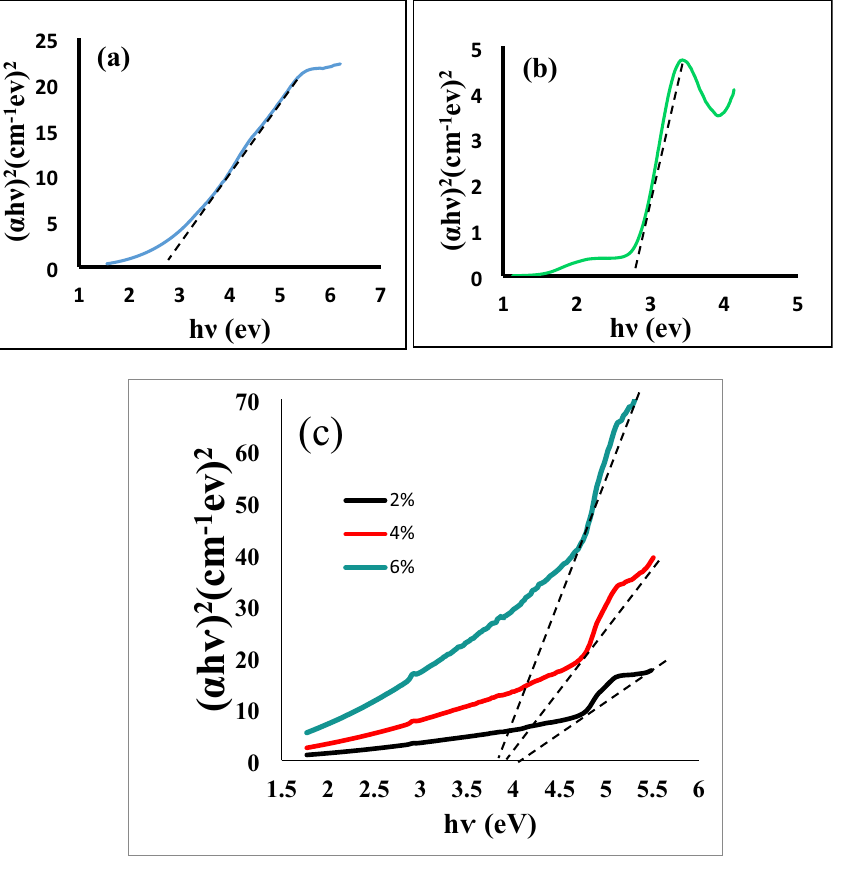
Figure 8. Tauc plots ( a – c ) showing indirect band gap values of ( a ) SnO 2 @ZnO nanocomposite, ( b ) PANI-NPs ( c ) different volume ratios of SnO 2 @ZnO.PANI (2%, 4%, and 6%)